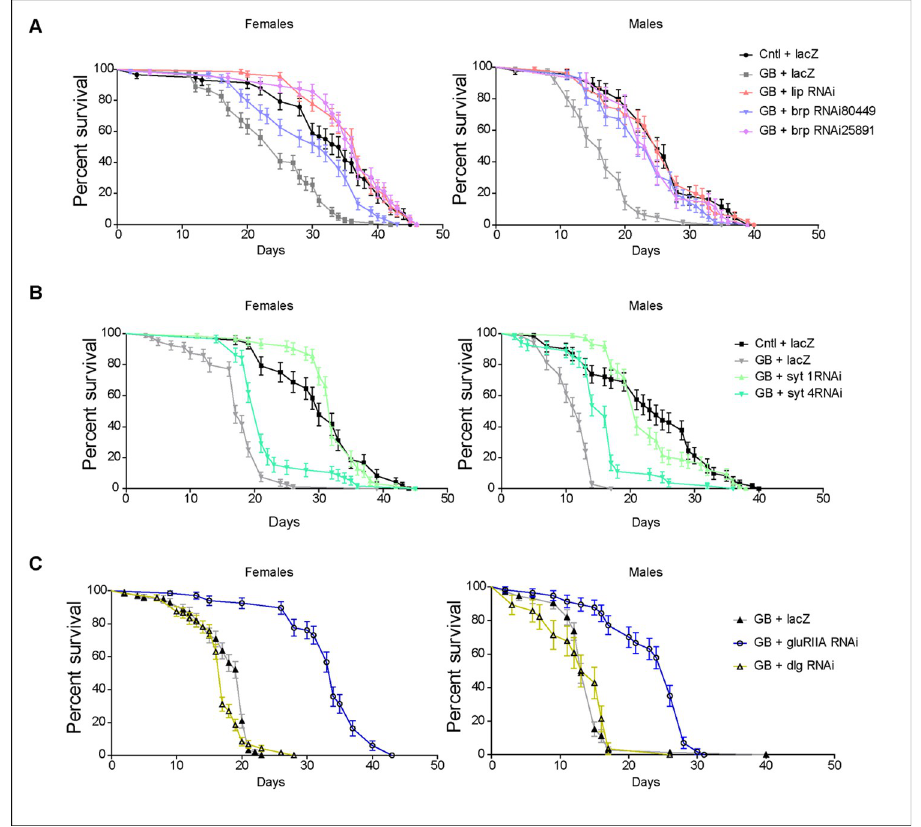
Fig 7. Synaptic genes contribute to premature death caused by glioblastoma. A) Graphs showing the percentage of survival of adult flies in control (black), GB (grey), GB + lip α RNAi (pale orange) and GB + Brp RNAi with two different RNAi lines (blue and purple). Females (left) and males (right) were analyzed separately. B) Graphs show the percentage of survival of control flies (black), GB (grey), GB + Syt 1 RNAi (bright green) and GB + Syt 4 RNAi (green). Females (left) and males (right) were analyzed separately. C) Graphs showing the percentage of survival of GB flies (grey), GB + glu RIIA RNAi (blue) and GB + dlg RNAi (yellow). Females (left) and males (right) were analyzed separately. No. � 30 animals. Logrank Test (Mantel-Cox) for trend analysis (All curve comparisons, ��� p > 0.0001). Raw numbers and complete genotypes are in S1 Table.